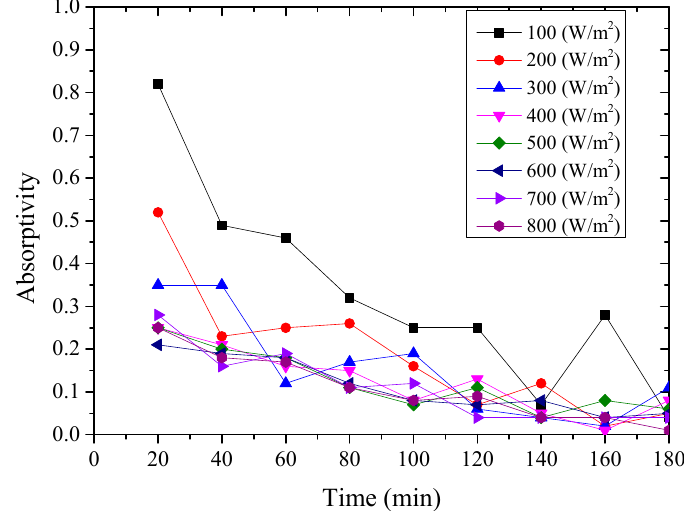
Figure 10. Variation of the instantaneous absorptivity for the nanoporous alumina sheet with 400 nm pore diameter.